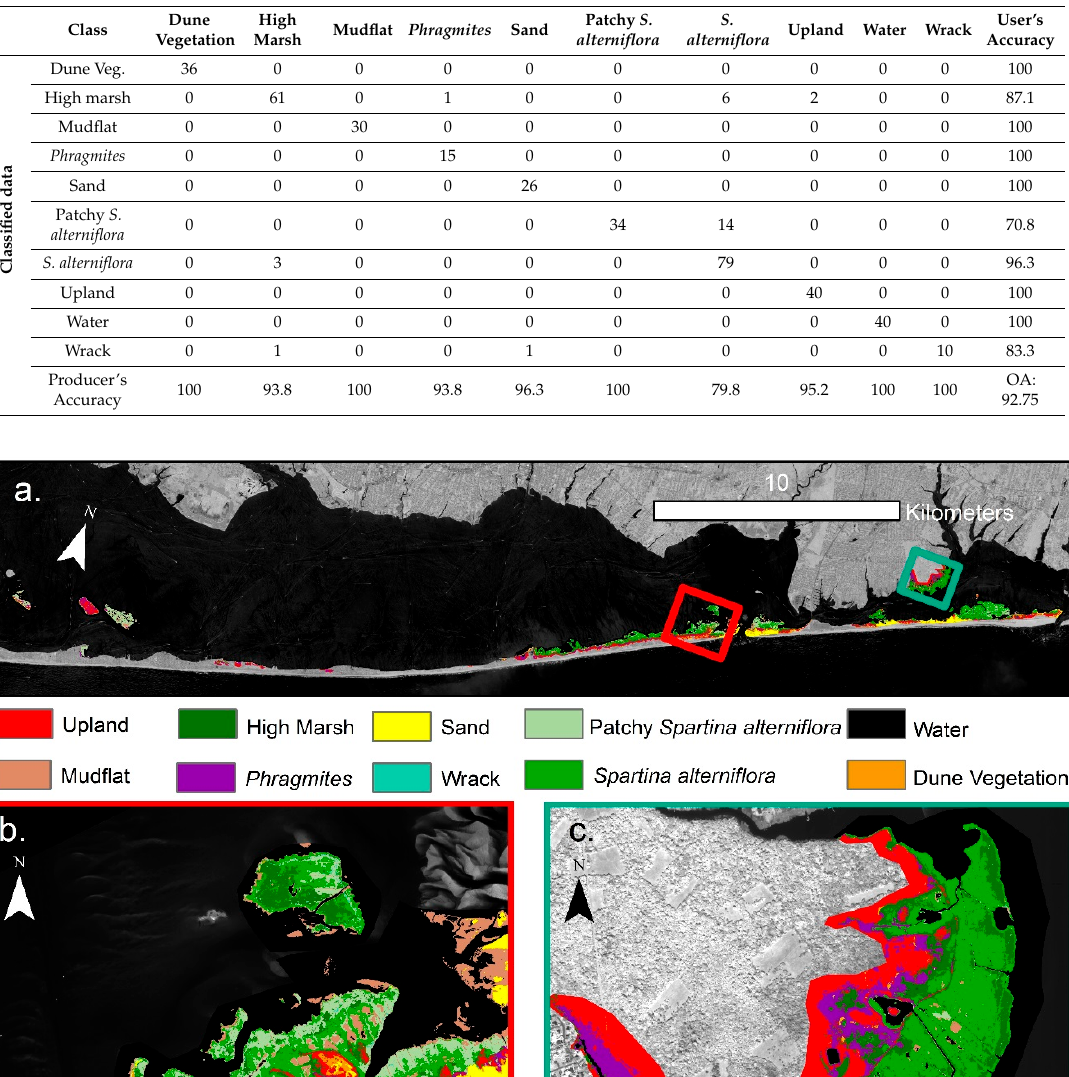
Table 2. An error matrix for the 2015 Worldview-2 / Worldview-3 classification of Fire Island National Seashore.